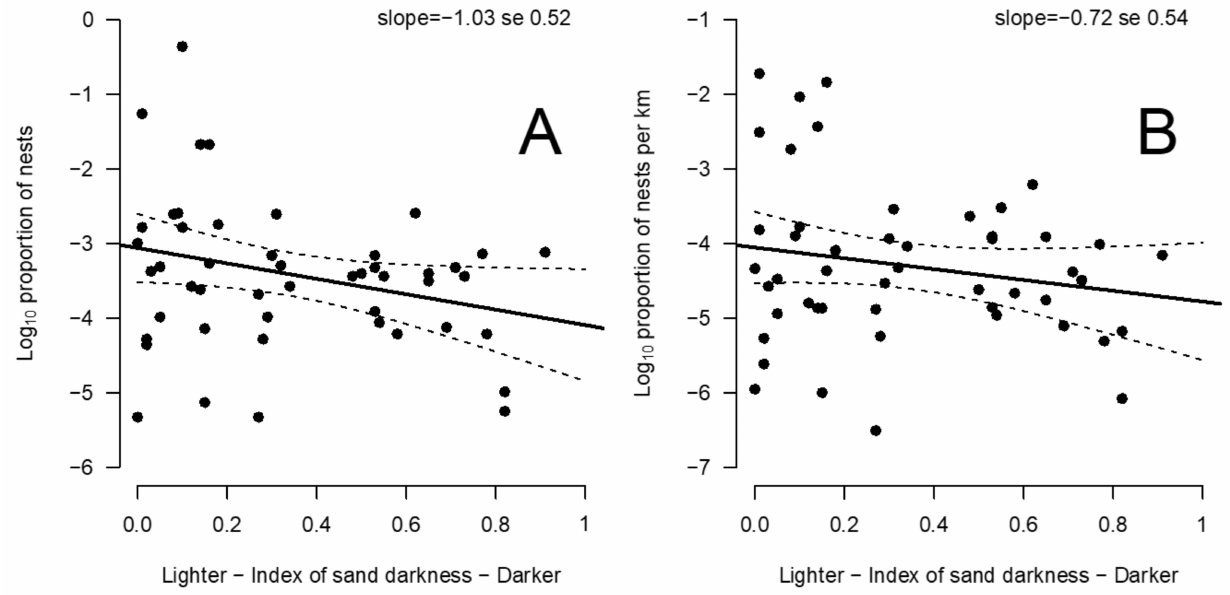
Figure 3. Relationship between sand darkness and ( A ) the proportion of olive ridley nests and ( B ) the proportion of olive ridley nests divided by beach length in Central American beaches. Note that the proportion of nests is log-transformed.